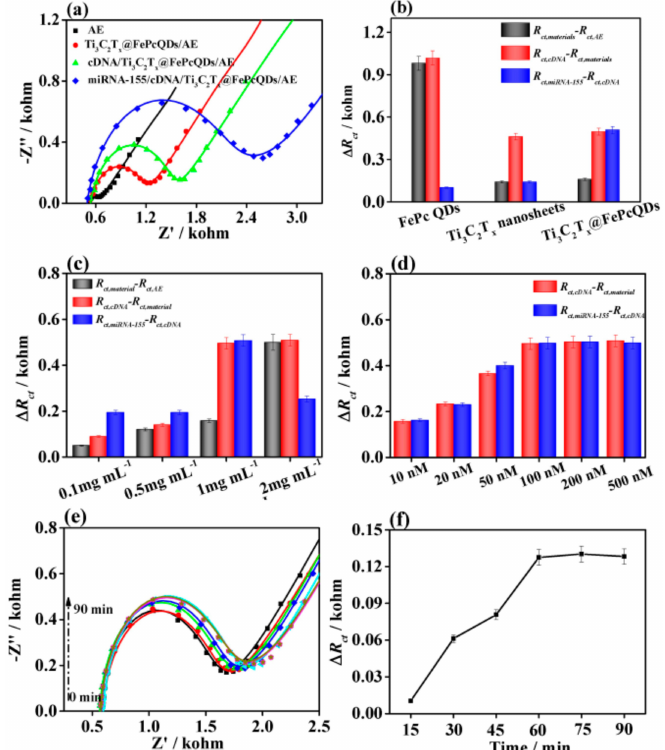
Figure 12. ( a ) Nyquist plots for various stages of development of the aptasensor for analysis of micro RNA-155 (miRNA-155) based on MXene@QD nanohybrid (QDs stands for quantum